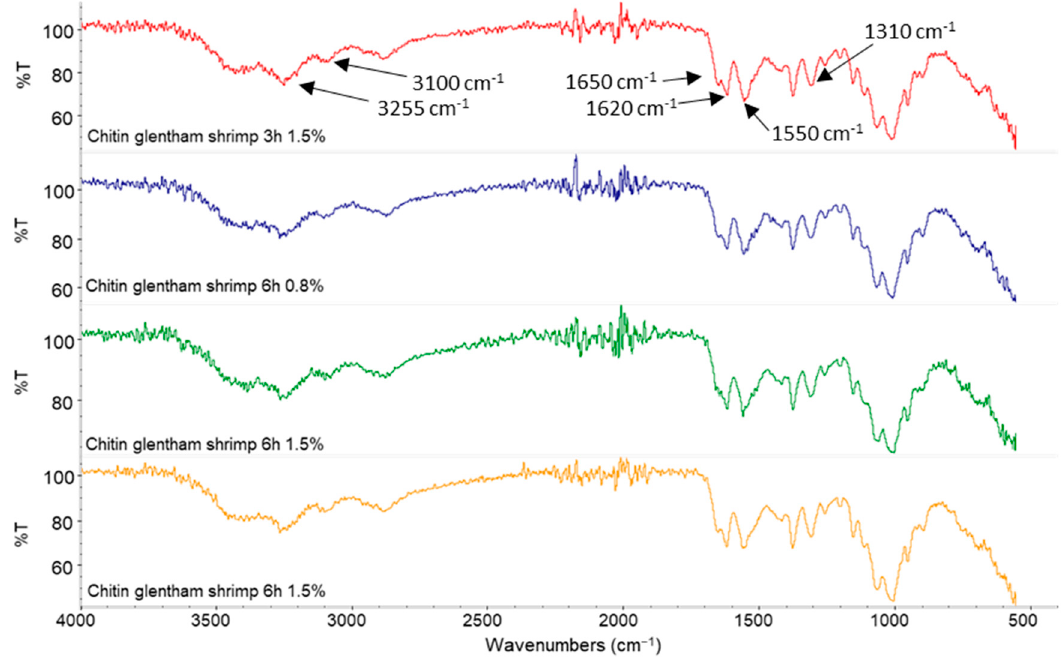
Figure 2. ATR-IR spectra of shrimp CN obtained at different time and concentration.